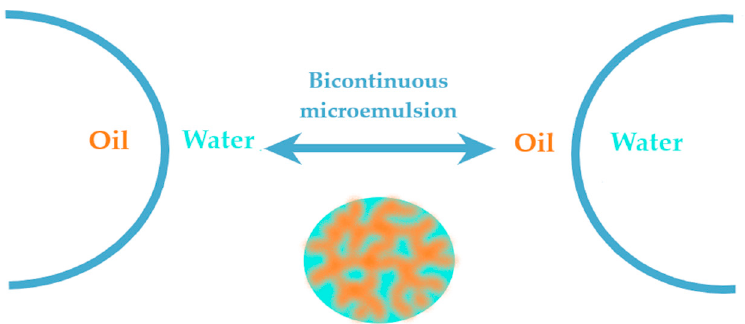
Figure 7. Schematic representation of phase transition in a microemulsion system with internal structure modification, from oil in water through water in oil type and vice versa, experiencing a particular bicontinuous state.